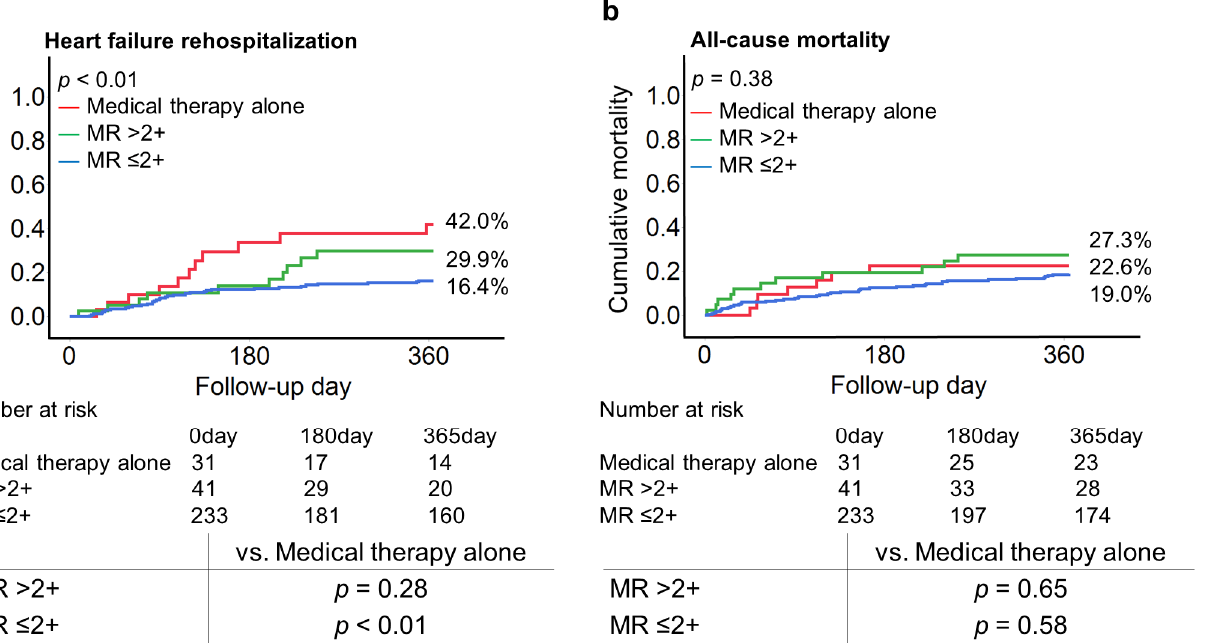
Figure 7. One-year heart failure hospitalization and all-cause mortality according to residual MR ≤ 2+, >2+ at discharge, and medical therapy alone. Patients with a reduction in MR to ≤ 2+ at discharge exhibited a lower event rate of heart failure rehospitalization compared to medical therapy alone (16.4% vs. 42.0%, p < 0.01) ( a ). However, patients with a residual MR >2+ at discharge showed comparable outcomes with those treated with medical therapy alone (Heart failure rehospitalization: 29.9% vs. 42.0%, p = 0.28; all-cause mortality: 27.3% vs. 22.6%, p = 0.65) ( b ). Abbreviations: MR, mitral regurgitation.